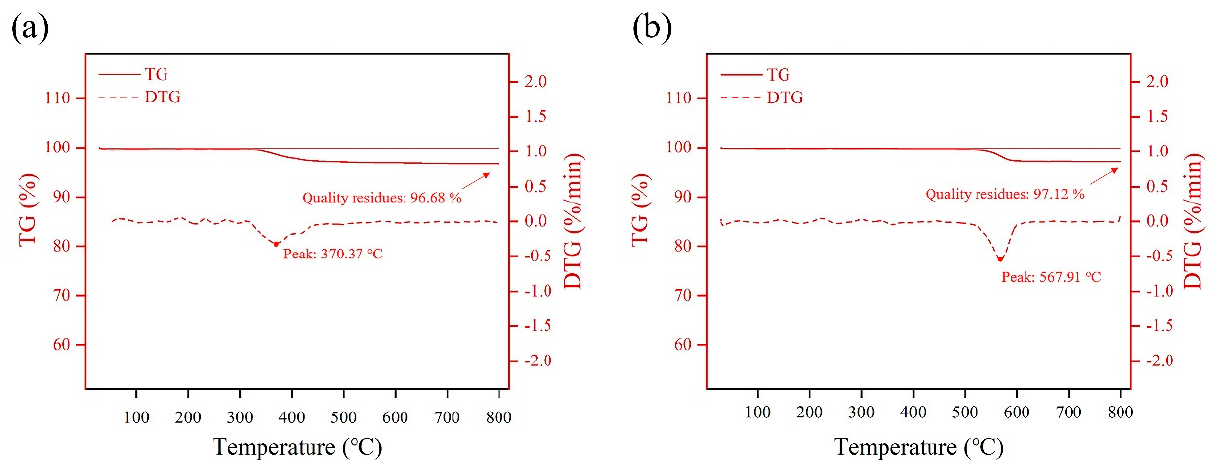
Figure 3. Water contact angle of ceramic membranes: ( a ) unmodified ceramic membrane; ( b ) PDMS- ceramic membrane; and ( c ) PTFE-ceramic membrane.